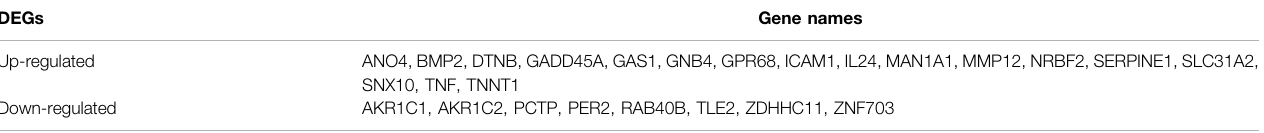
TABLE 1 | Twenty fi ve DEGs were identi fi ed from two mRNA pro fi les (GSE45670 dataset and GSE137867 dataset), including 17 upregulated genes and 8 down-regulated genes in the ESCC responder groups compared with control non-responder groups. DEGs